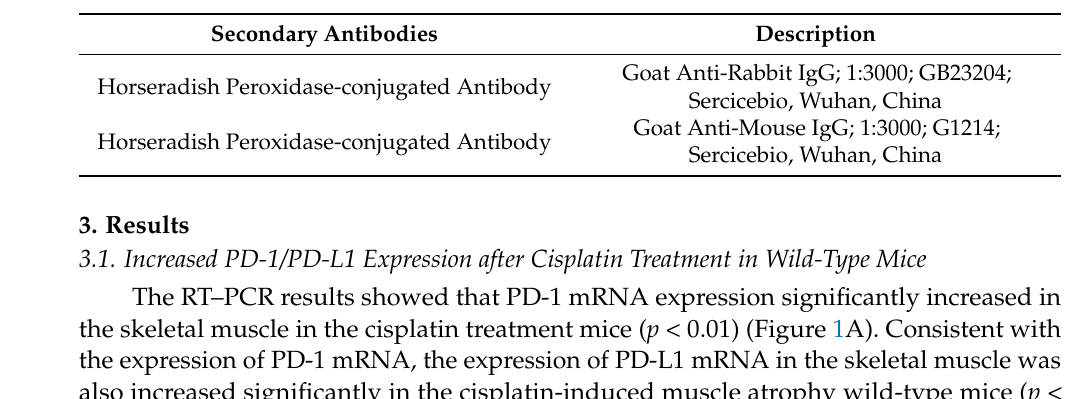
Table 3. Secondary antibodies used for Western blot experiments.